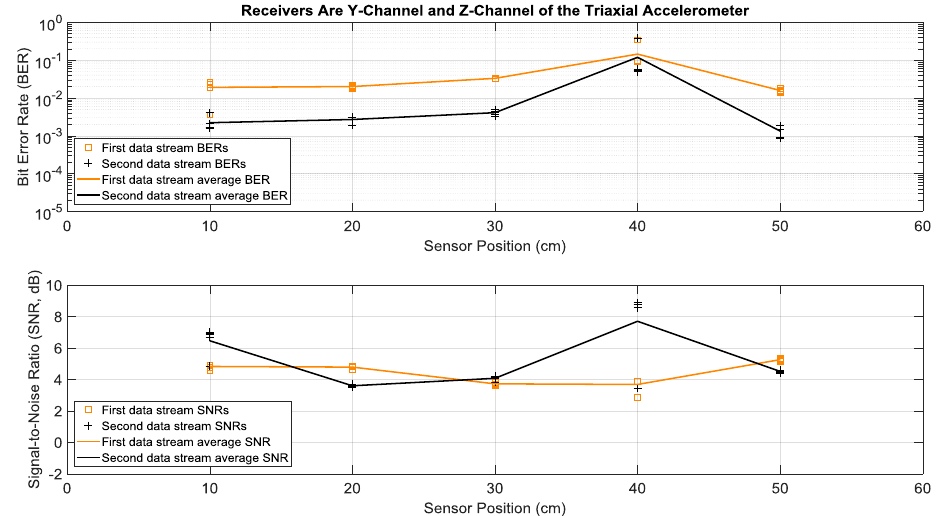
Figure 11. BERs ( top ) and SNRs ( bottom ) at different receiver positions, with two actuators transmitting two data streams simultaneously. The receivers were the y -channel and z -channel of a triaxial accelerometer. The piecewise linear graphs represent the average BERs and SNRs for each of the two data streams versus the receiver position.